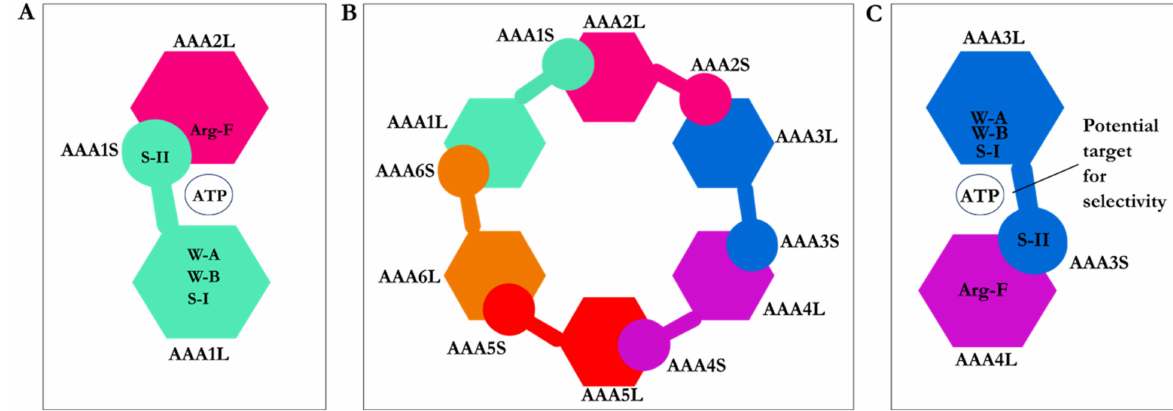
Figure 2. Composition of the AAA+ subdomains. ( A ) The AAA1 nucleotide-binding site composed of the small (AAA1S) and large (AAA1L) subunits of AAA1 and the prominent (AAA2L) subunit of AAA2. ATP motifs are represented: walker-A (W-A), walker-B (W-B), sensor I (the S-I), sensor II (the S-II) in AAA1, and Arginine finger (Arg-F) in AAA2, ( B ) Hexameric head of cytoplasmic dynein, ( C ) The AAA3 nucleotide-binding site composed of its small (AAA3S) and large (AAA3L) subunits and the large subunit of AAA4. ATP motifs are represented as the walker-A (W-A), the walker-B (W-B), the sensor I (the S-I), the sensor II (the S-II) in AAA3, and the arginine finger (Arg-F) in